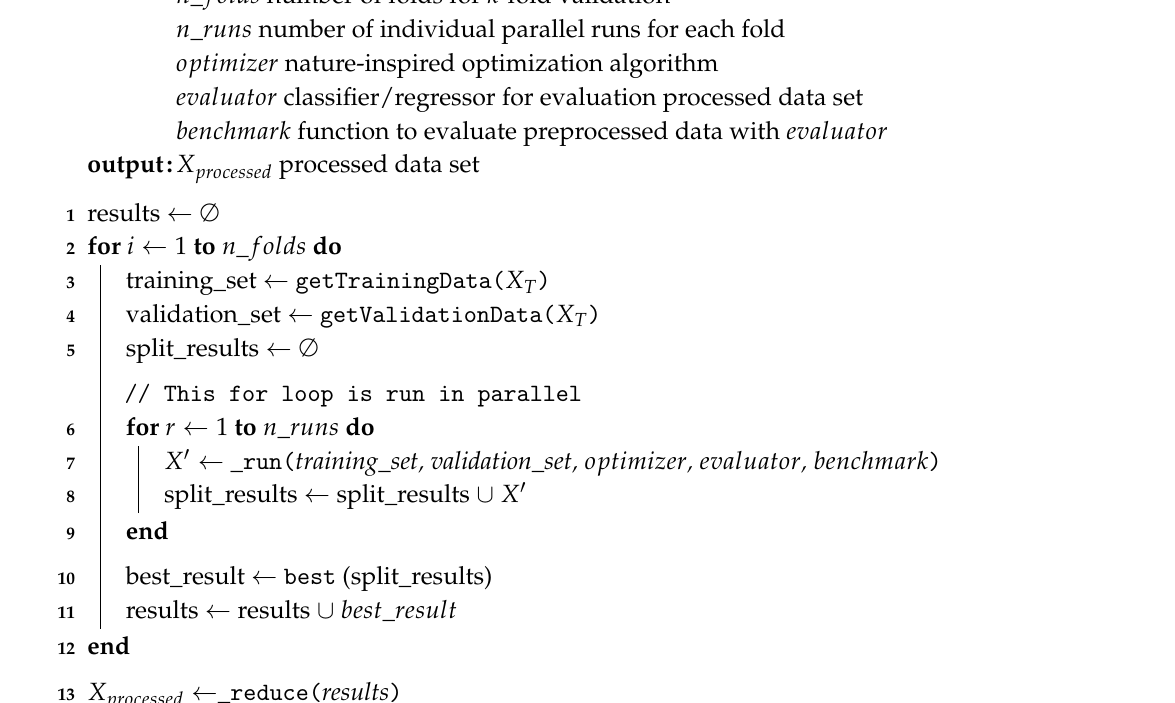
Algorithm 1: Base procedure for running preprocessing optimization. input : X T training data